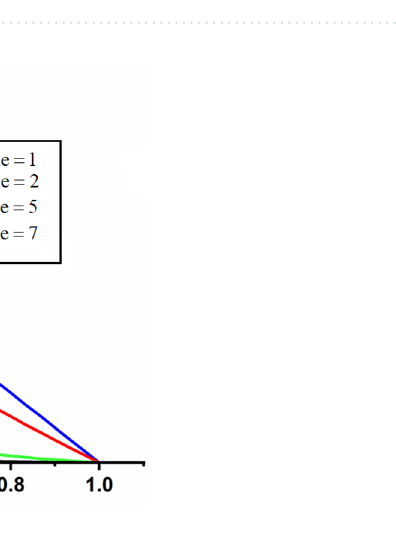
Figure 18. The impact of β on couple stress fluid concentration profile when, α = 0.5 , t = 0.2 , Sc = 0.5 and Re = 3 .